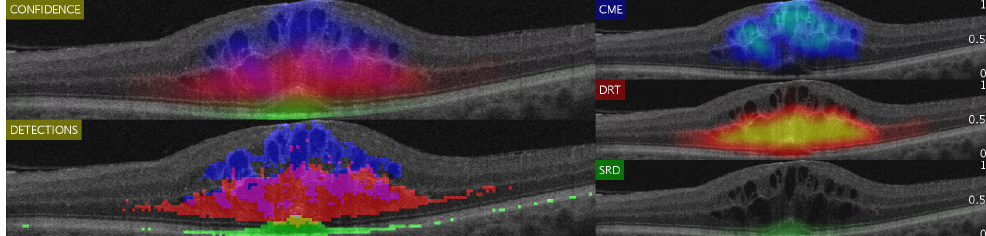
Figure 6. Example of a generated image showing all five different points of view. As shown, leftmost representations give a general idea of the interaction between DME types. On the other hand, the rightmost maps present a more detailed characterization.